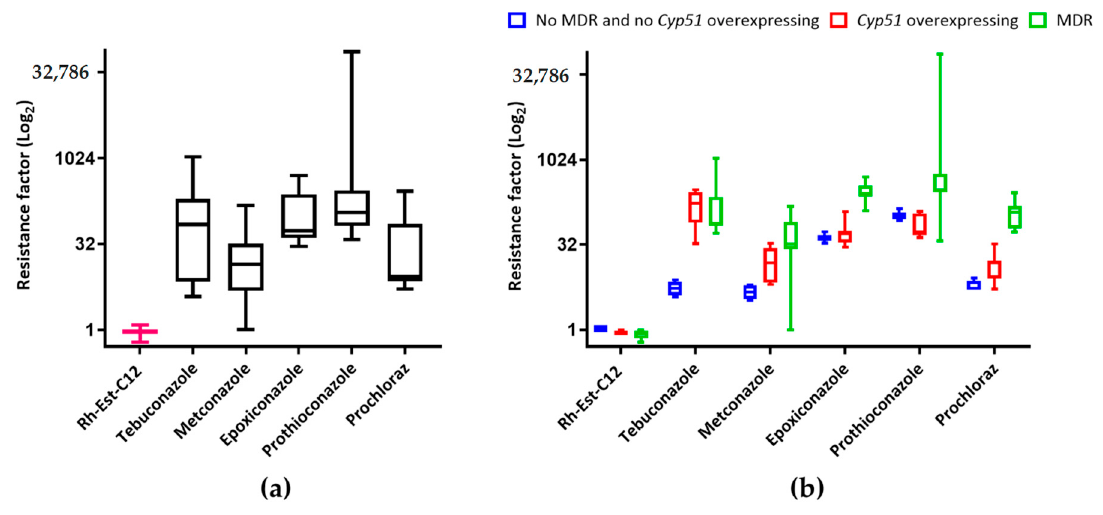
Figure 4. Boxplots showing the resistance factors obtained for 21 different Zymoseptoria tritici strains analyzed together ( a ) or distinguished according to their DMI resistance profiles (seven MDR strains, seven strains overexpressing the Cyp51 gene, and seven strains without these resistance mechanisms) ( b ), against five DMI fungicides as well as the RL molecule Rh-Est-C12. Resistance factors correspond to the ratio between the IC 50 value of a given strain and the IC 50 value of the sensitive reference strain IPO323.